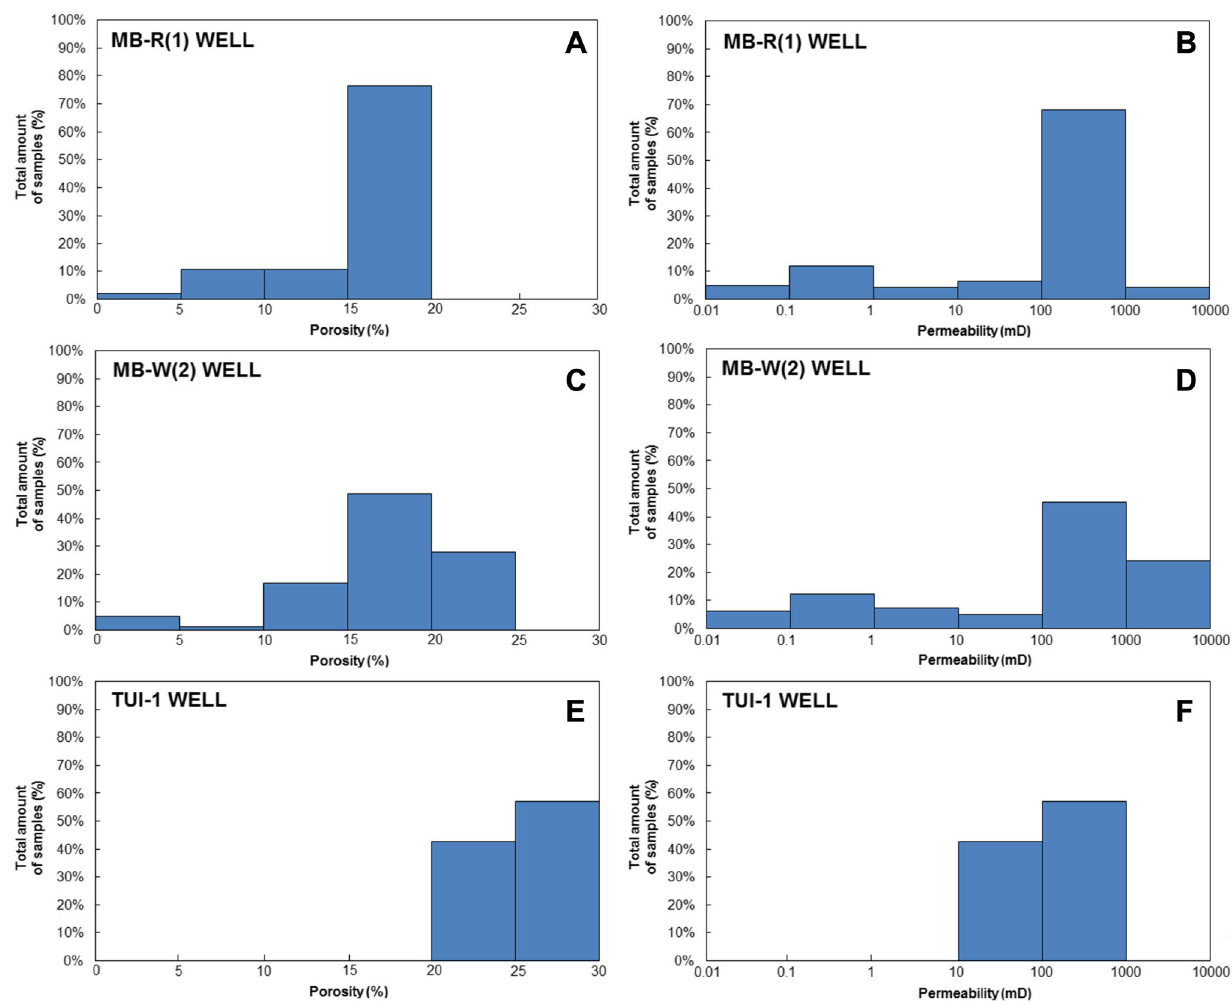
Fig. 6 Permeability and porosity histograms for MB-R(1), MB-W(2) and Tui-1